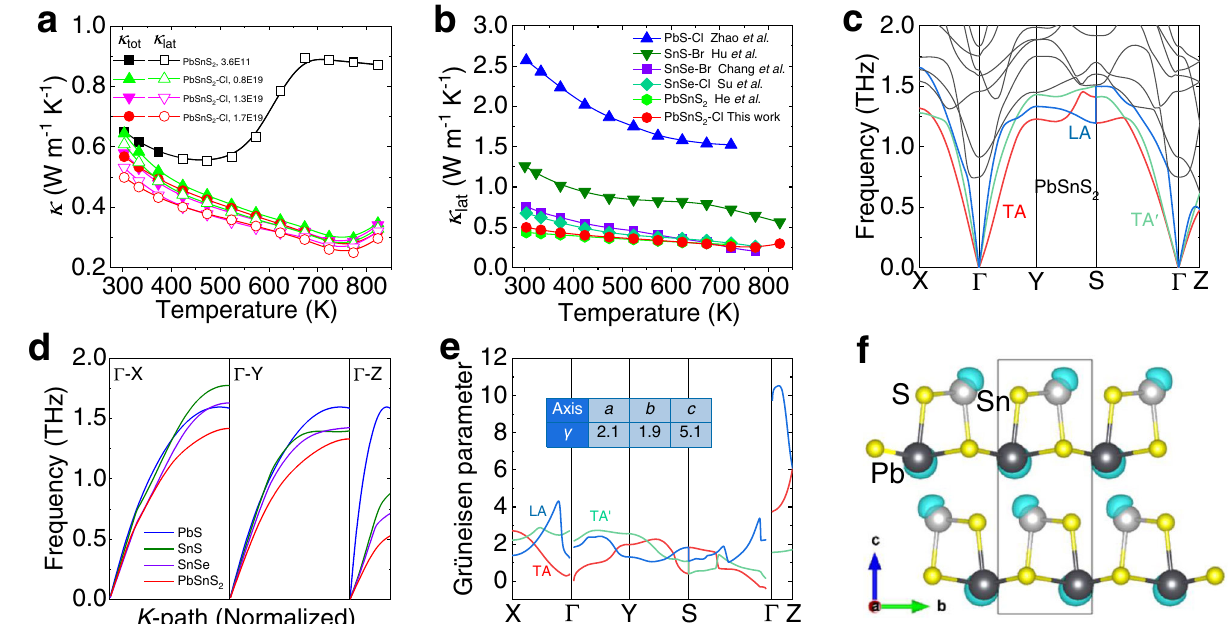
Fig. 5 | Temperature-dependent thermal transport performance of undoped and Cl doped PbSnS 2 along the out-of-plane direction and theoretical calcu- lationresults.a Thermalconductivity. b Latticethermalconductivitycomparisons of n -type lead and tin chalcogenides, including Cl doped PbS polycrystal 45 , Br- doped SnScrystal 23 , Brand CldopedSnSecrystals 9,38 ,and PbSnS 2 polycrystal 35 and